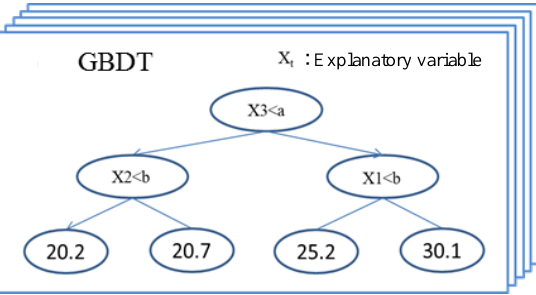
Figure 5. Overview of GBDT.